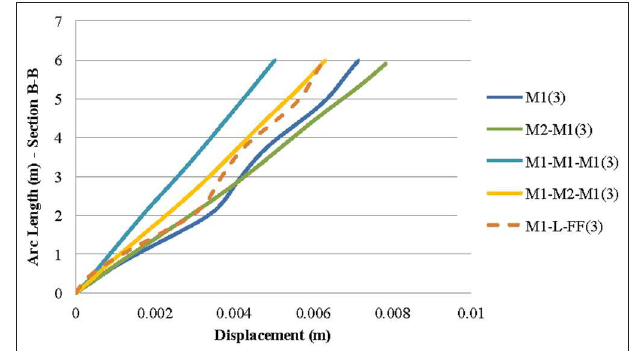
FIGURE 7 | Displacements across section A-A for the first (11.09Hz) (A) and the fourth mode (15.5–16Hz) (B) of models: M1, M2, M2-M1, M1-M1-M1, M1-M2-M1, and